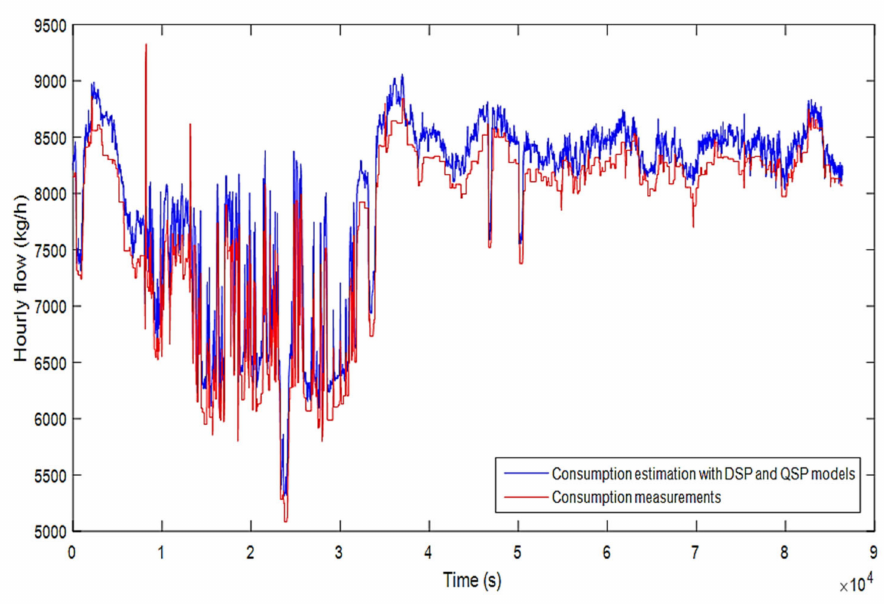
Figure 19. DSP and QSP day, evolution of measured and estimated